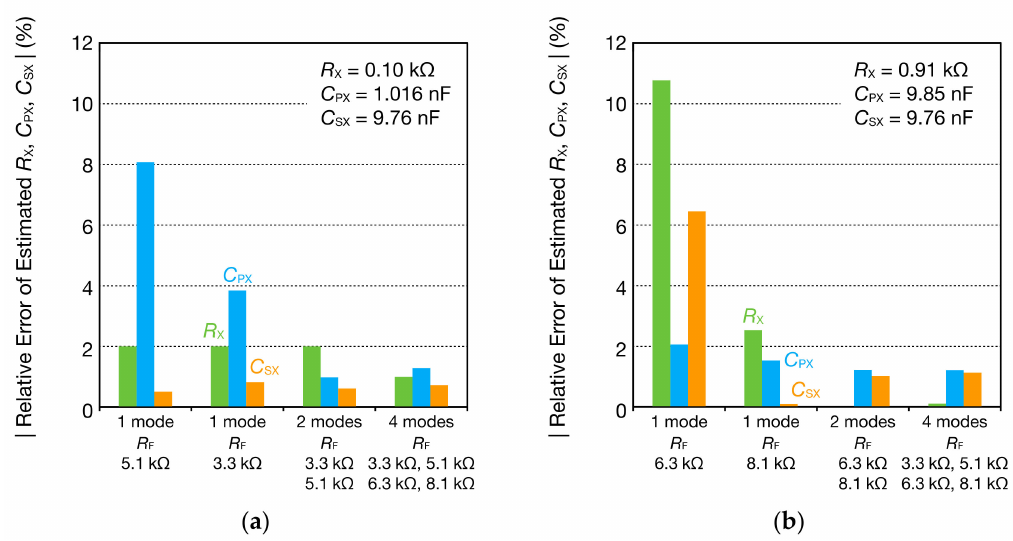
Figure 7. Absolute relative estimation errors of the circuit parameters of parallel RC circuits: ( a ) R X = 0.10 k Ω , C PX = 1.016 nF, and C SX = 9.76 nF; ( b ) R X = 0.91 k Ω , C PX = 9.85 nF, and C SX = 9.76